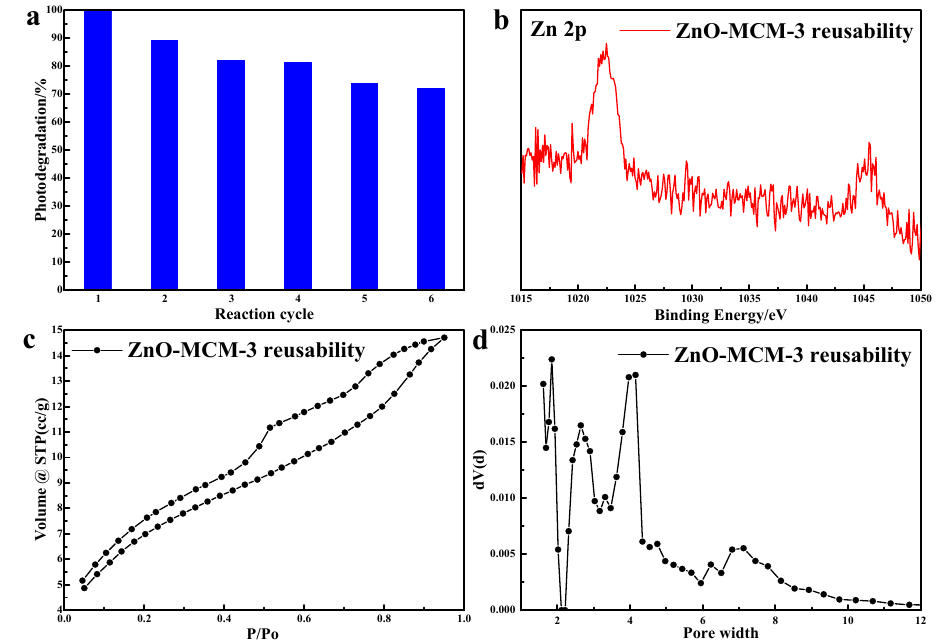
Figure 12. Reusability of ZnO-MCM-3 toward the photodegradation of MO ( a ), XPS of Zn 2p ( b ), N 2 adsorption/desorption isotherms ( c ) and pore size distribution ( d ).